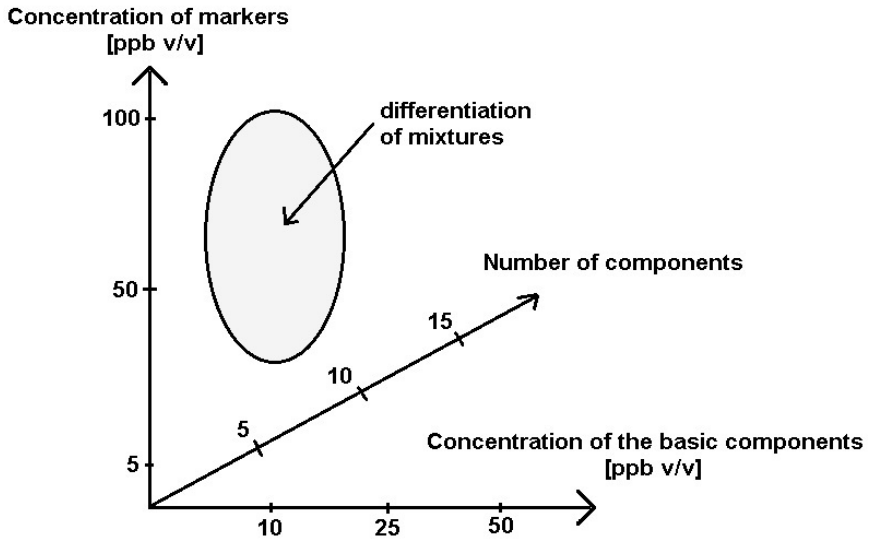
Figure 12. Schematic presentation of differentiation between the mixtures with COPD markers using electronic nose